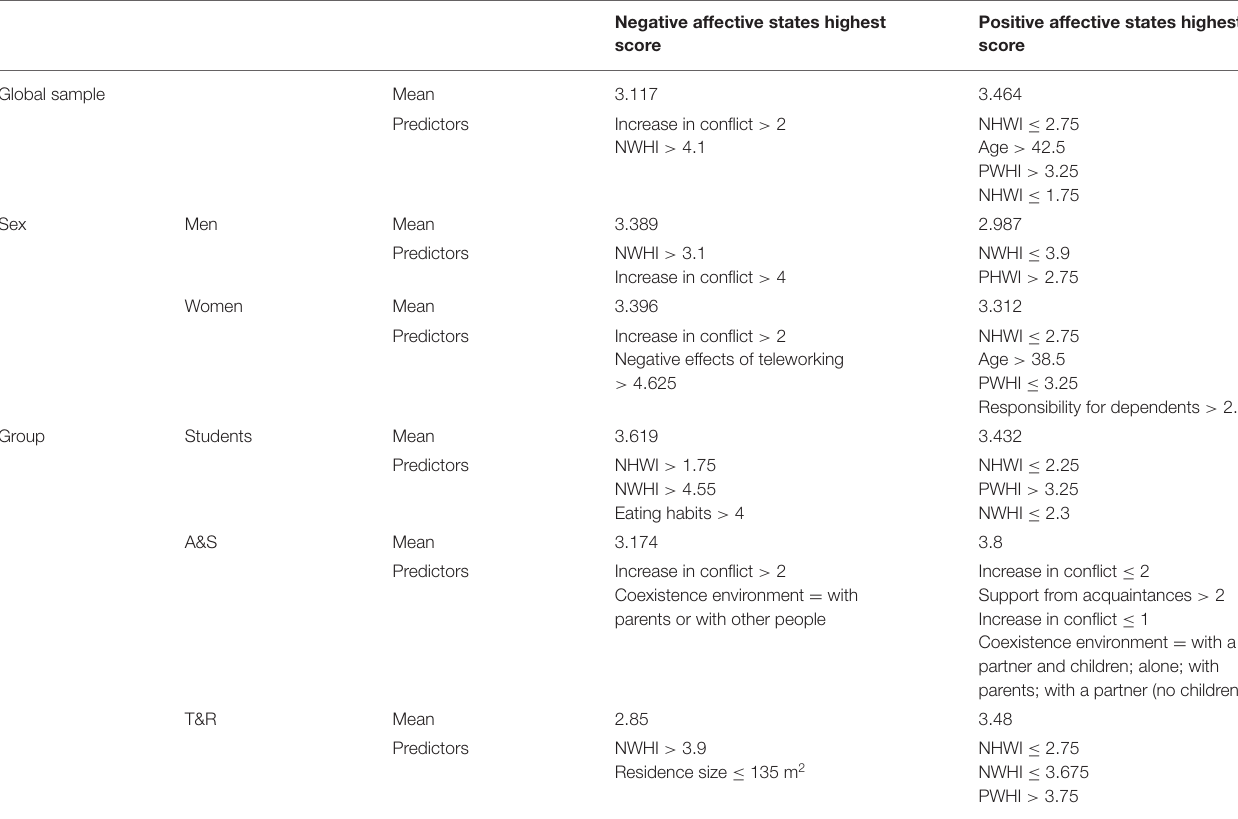
TABLE 3 | Comparison of groups with the highest scores in affective